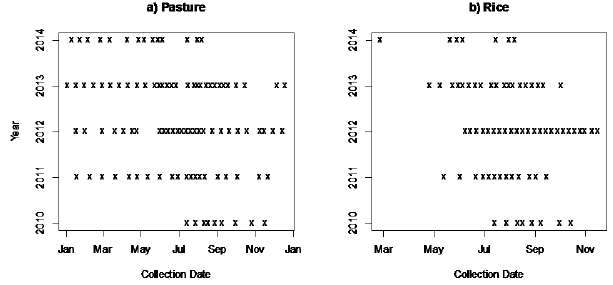
Figure 1. Canopy hyperspectral field collection dates. This anal- ysis synthesized canopy hyperspectral reflectance measurements collected from 2010 to 2014 at Pasture and Rice sites in the Sacramento–San Joaquin Delta in northern California. On each sampling date we collected nine individual canopy hyperspectral re- flectance replicates at the Pasture site and five individual reflectance replicates at the Rice